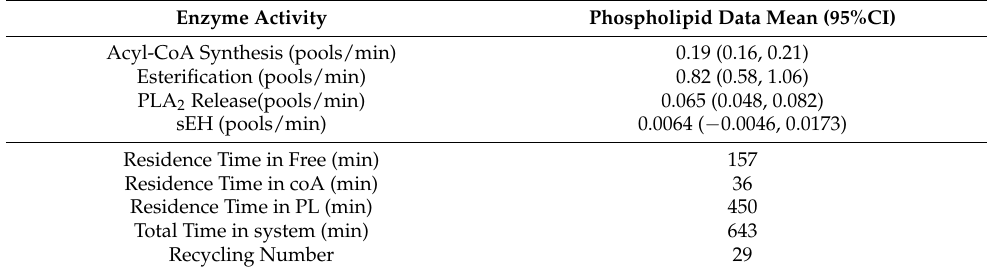
Table 2. Kinetic parameters for published epoxide models. Karara et al. studied the incorporation of labeled free epoxide as 1- 14 C 14(15)-EpETrE, into phospholipids of microsomal fractions from homogenized rat livers [60]. The fraction of label in free epoxides and phospholipid-epoxides were measured by liquid scintillation for several time points over 20 min. By 20 min, the fraction of label in phospholipids was stable at about 70%, indicating a steady state. The data were digitally extracted and used to construct a mathematical compartmental model and calculate the kinetic parameters presented here (see Figure 2 for construct and model fit). The calculated recycling number is the average number of times a labeled molecule was recycled through the system [residence time/transient time − 1] when entering the system from compartment 1, where residence time is − 1 × (the value from the inverse matrix). CoA, coenzyme A; PL, phospholipid; PLA 2 , phospholi- pase A-2; sEH, soluble epoxide hydrolase. Enzyme